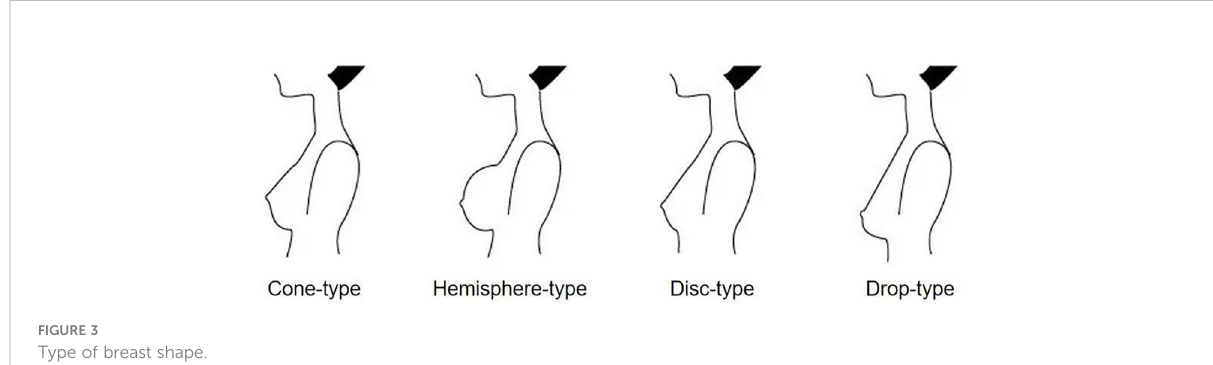
FIGURE 3 Type of breast